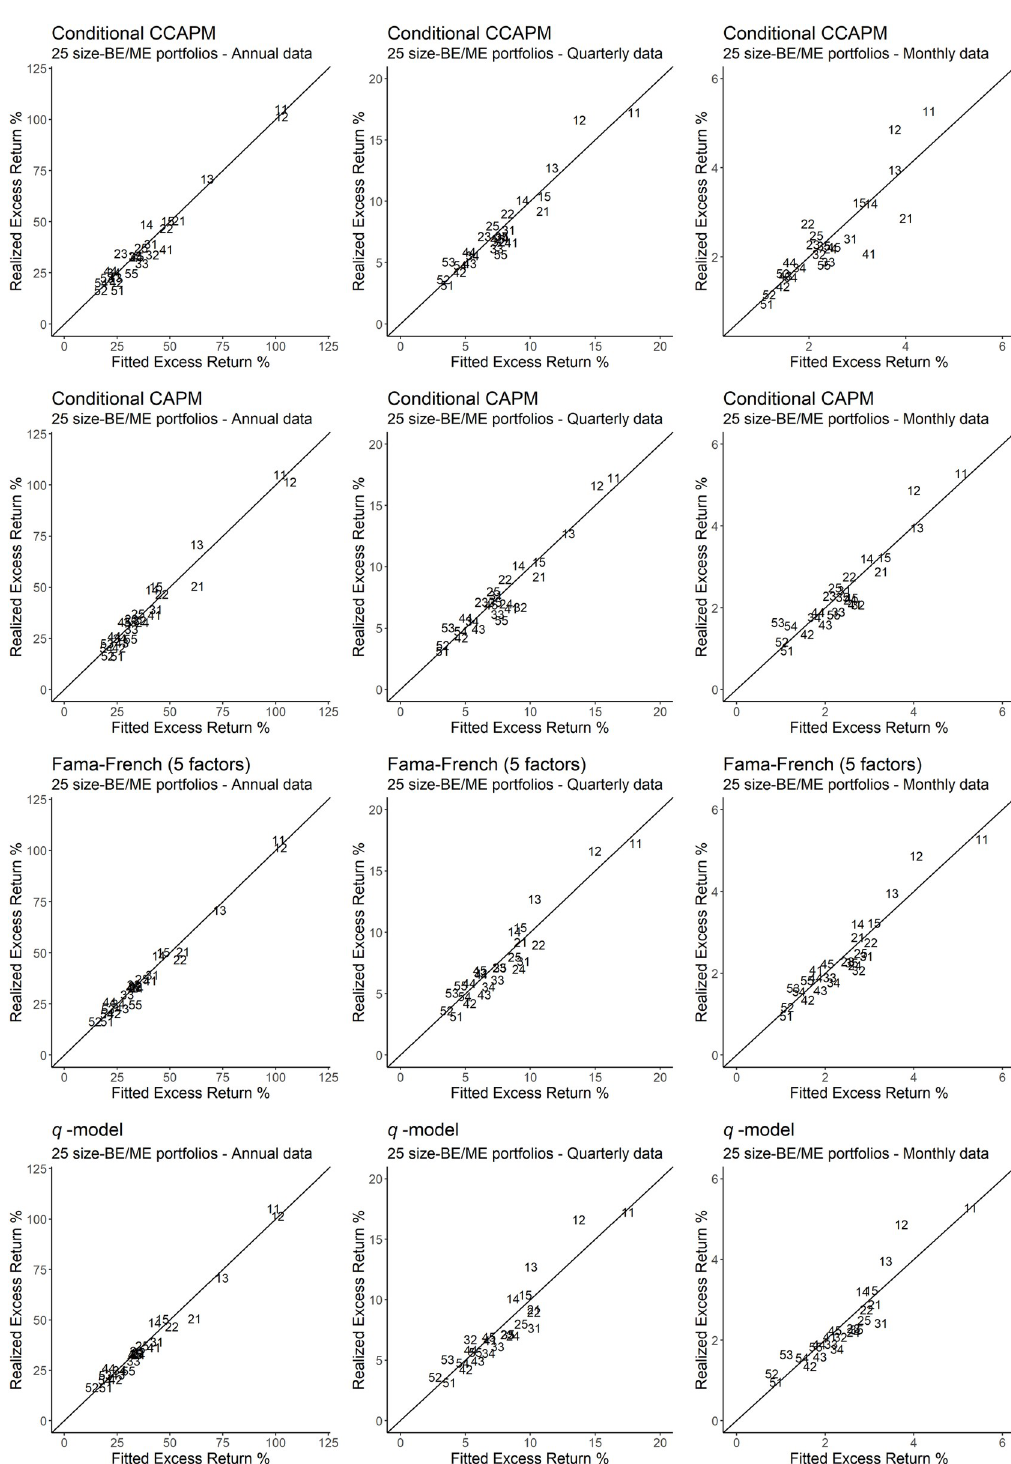
Fig 1. Realized excess returns versus fitted values for 25 portfolios size-BE/ME. The figure depicts 25 portfolios size-BE/ME using a code with two numbers, the first number being the size code (with 1 being the smallest and 5 the largest) and the second number being the BE/ME ratio code (with 1 representing a low ratio and 5 a high ratio). The closer the portfolios are to the 45 degrees axis, the better the fit produced by the model.